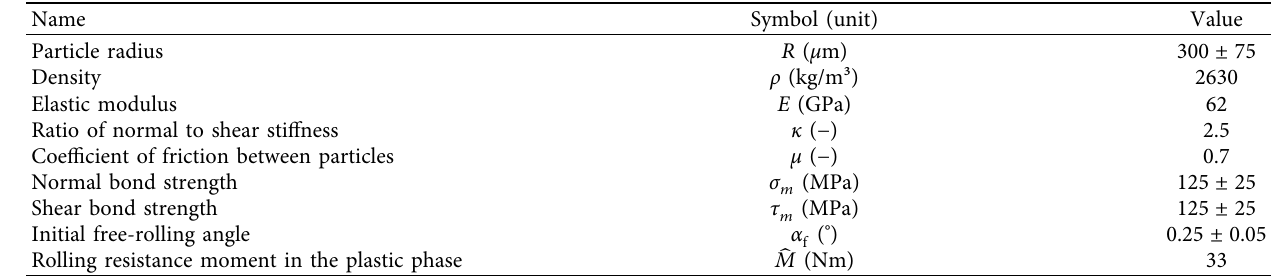
Figure 6: Boundary conditions in the DEM cutting Table 1: Calibrated microparameters of the DEM model.